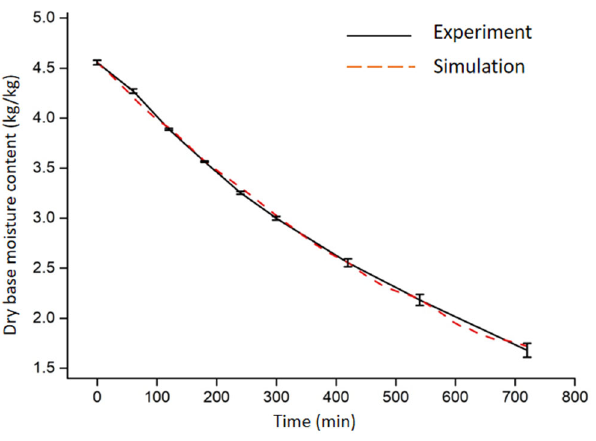
Figure 7. Moisture content of potato samples during RF drying from both simulation and experiment.